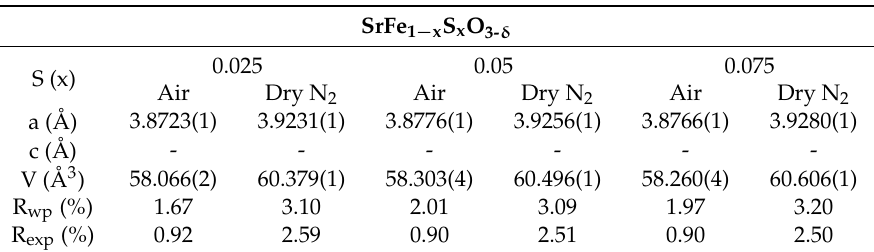
Figure 5. X-ray diffraction patterns of ( a ) SrFeO 3- δ , ( b ) SrFe 0.975 S 0.025 O 3- δ , and ( c ) SrFe 0.95 S 0.05 O 3- δ after heating under N 2 to 950 °C. Table 2. Lattice parameters for SrFe 1 − x S x O 3- δ after heating in air and N 2 .